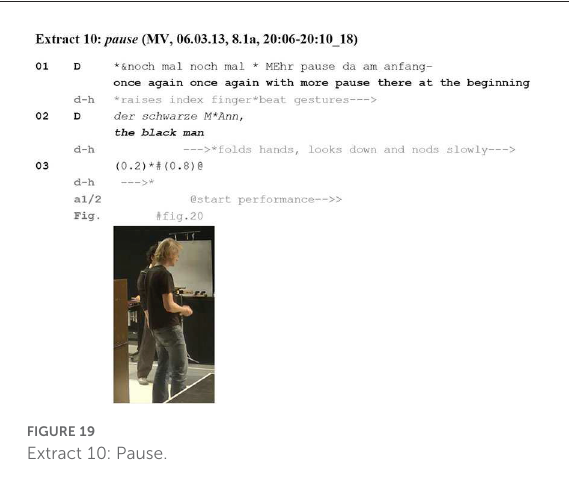
FIGURE19 Extract 10: